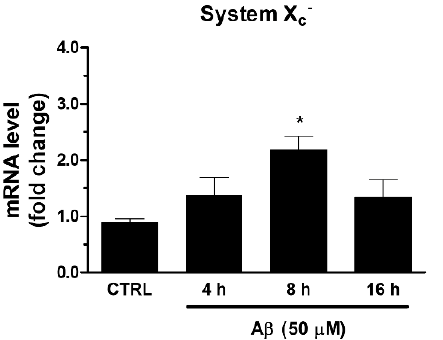
Figure 3. Effects of Aβ 25-35 on System X c− gene expression in U373 cells. Cells were treated with Aβ 25- 35 (50 µM) for 4, 8, and 16 h. After incubation at 37 °C, cells were homogenized, and total RNA has been purified to evaluate mRNA content of System X c− by RT-qPCR. Results are computed relative to GAPDH content, taken as a housekeeping gene. Bars are the means ± SEM from three separate experiments, each performed in duplicate. One-way ANOVA, followed by Bonferroni’s test, was used to define significant differences. * p ≤ 0.05 vs. CTRL.